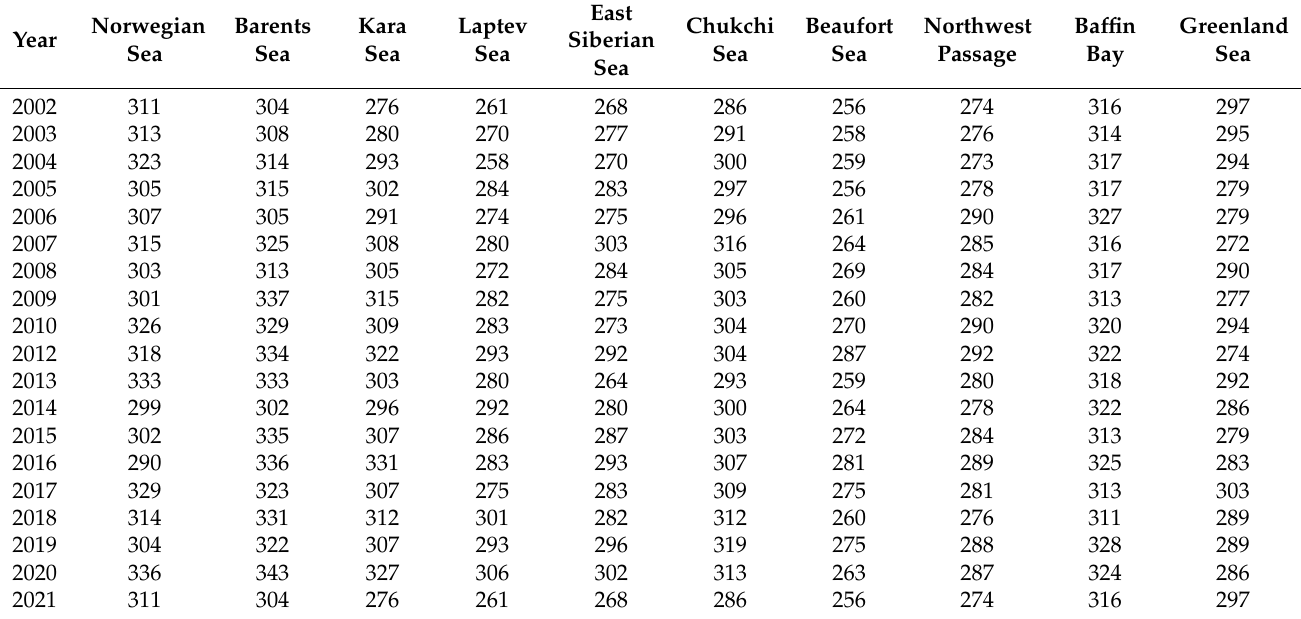
Table 6. The DoY of Arctic sea ice freeze-up from 2002 to 2020.